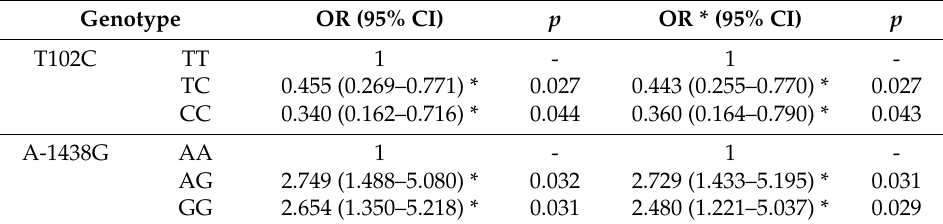
Table 6. The risk of mental health